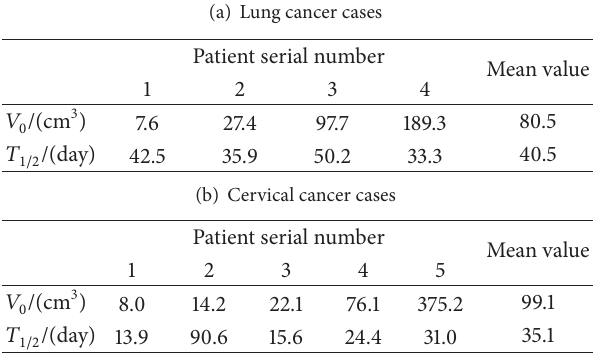
Table 1: Initial tumor volume ( 𝑉 0 ) and volume halving time ( 𝑇 1/2